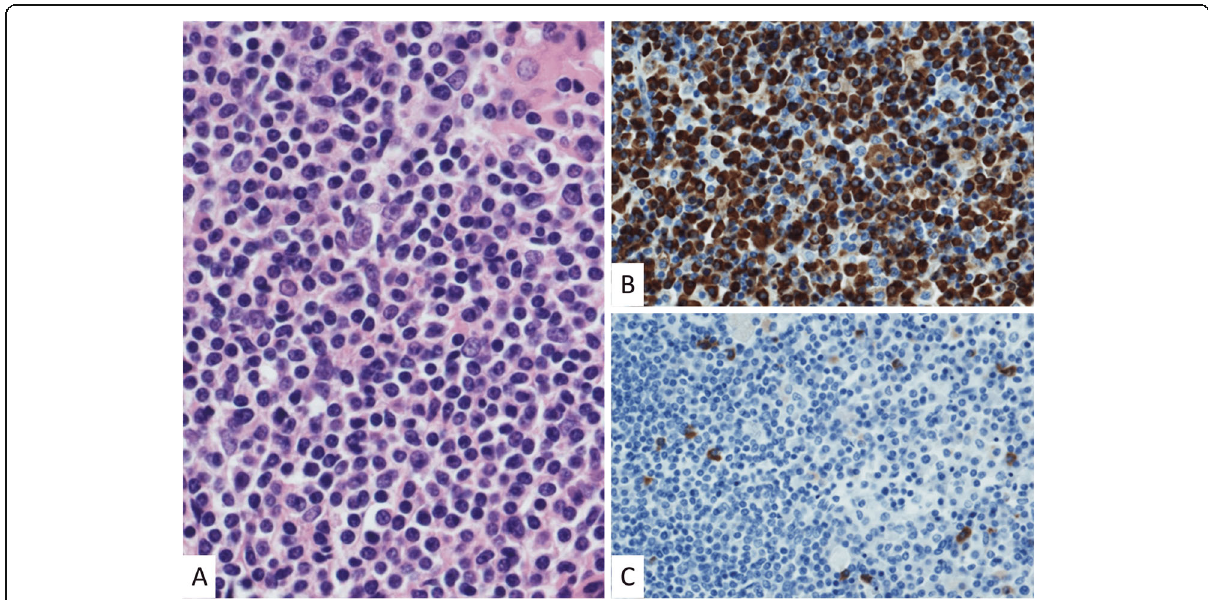
Fig. 5 Histopathological findings of the mediastinal mass showing small- to medium-sized atypical lymphoid cells, and some of them exhibit plasmacytoid differentiation in the hematoxylin and eosin staining ( a ). A light chain restriction positive for kappa ( b ) and negative for lambda ( c ) chains is demonstrated. We used antibodies with the product number N1510 (company, DAKO; dilutions, 5 times for the kappa chains) and product number NCL-LAM (company, Leica; dilutions, 200 times for the lambda chains). The positive cells are stained with a brown